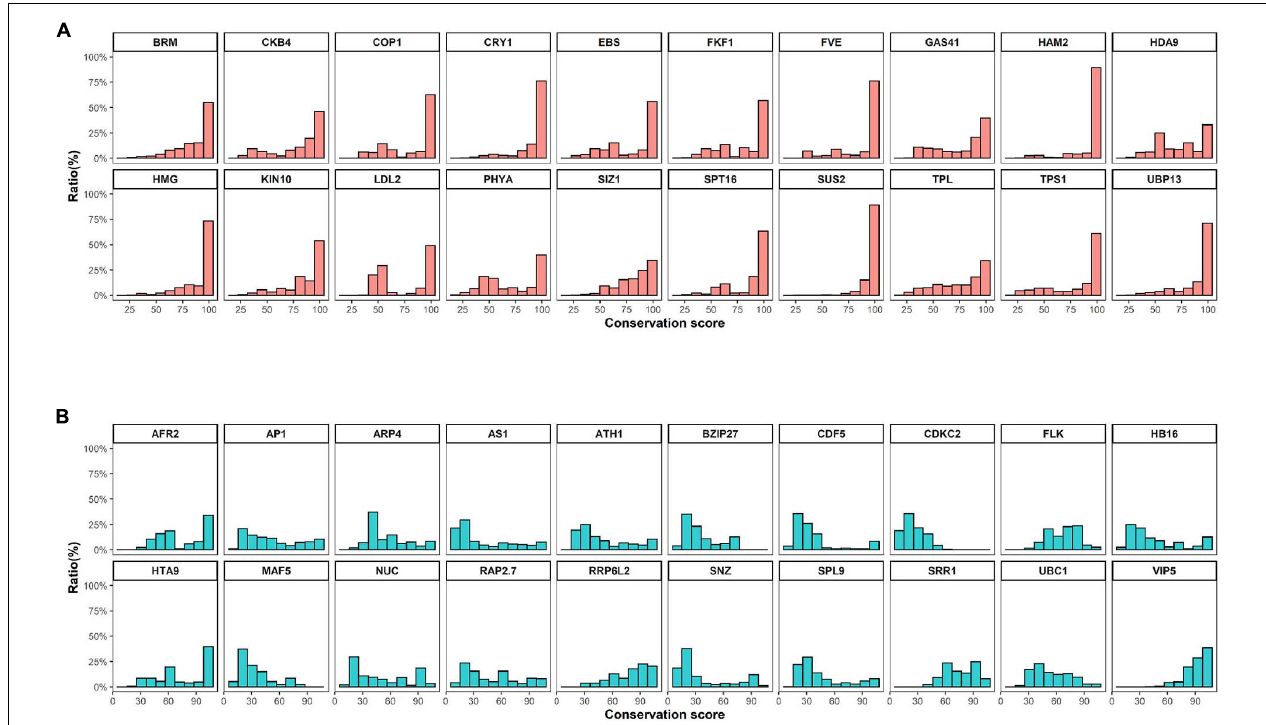
FIGURE 2 | Conservation scores of conserved and variable proteins. (A) and (B) The top 20 (A) conserved or (B) variable proteins were selected by their domain architectures and filtered based on comparison of protein length with Arabidopsis templates. Conservation scores were calculated using methods described in a previous study (Koo et al.,